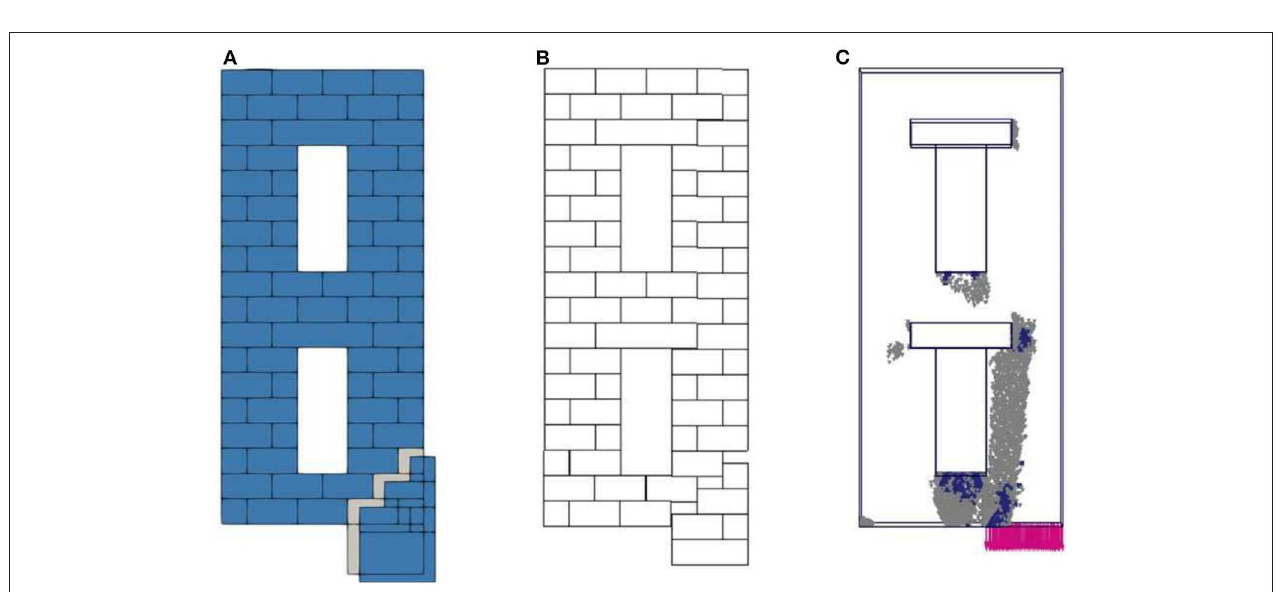
FIGURE 10 | (A) LA, (B) FEM/DEM, and (C) FEM results for Panel 3 case.